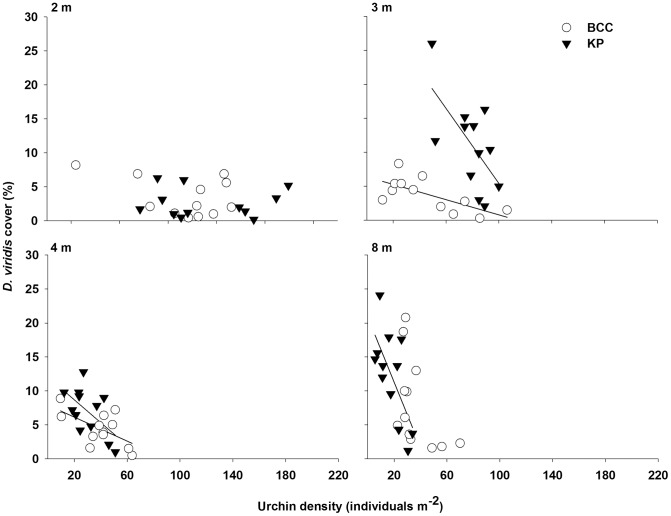
Relationships between Desmarestia viridis cover and urchin (Strongylocentrotus droebachiensis) density at 2, 3, 4, and 8 m depths at Bread and Cheese Cove (BCC) and Keys Point (KP) from 8 April to 23 September, 2011.Each data point is the mean cover and corresponding mean density calculated from the 10 frames of each pair of transects for a given site, depth, and date. Solid lines are the linear regression fits to data for each site (p<0.05; n = 12) (see Table 2 for the details of the regressions).